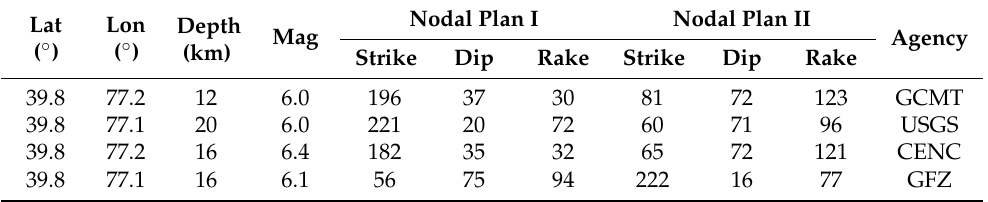
Table 1. Focal mechanisms and fault parameters reported by different